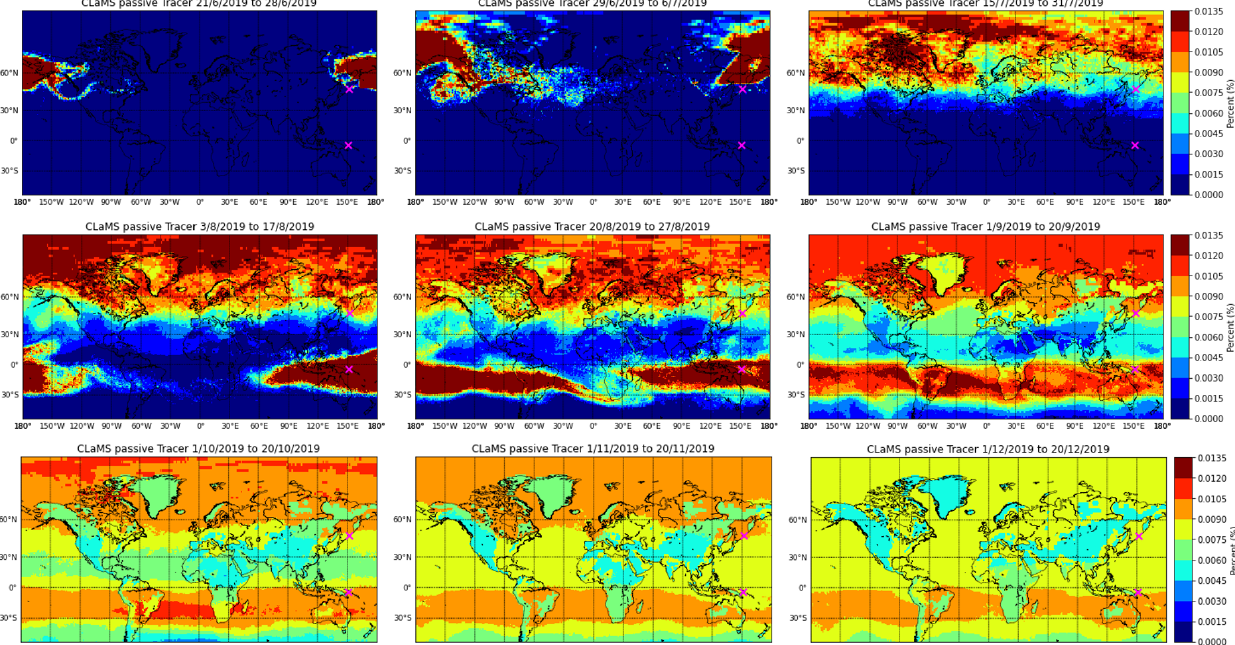
Figure 6. Mean column air mass fraction from the Raikoke and Ulawun plumes, calculated from integrating the passive CLaMS air mass tracers over all vertical levels. The two main eruptions (Raikoke 21 June and Ulawun 3 August) are equally included. Initialized boxes are selected according to Himawari and IASI observations. The Raikoke eruption is initialized from 23–24 June, 163 ◦ E–170 ◦ W, 49–62 ◦ N and 335–460K. The Ulawun eruption is initialized from 3 to 4 August, 137–178 ◦ E, 10 ◦ S–5 ◦ N and 350–385K. The magenta cross symbols indicate the locations of the two